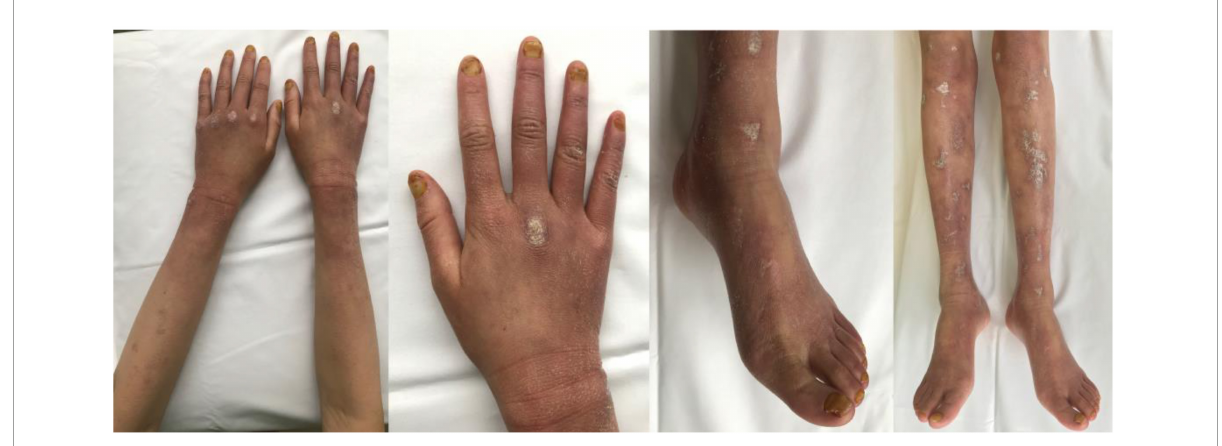
FIGURE3 Evident regression of the cutaneous lesions of the patient’s arms, hands, legs, and feet after the antiplatelet therapy.